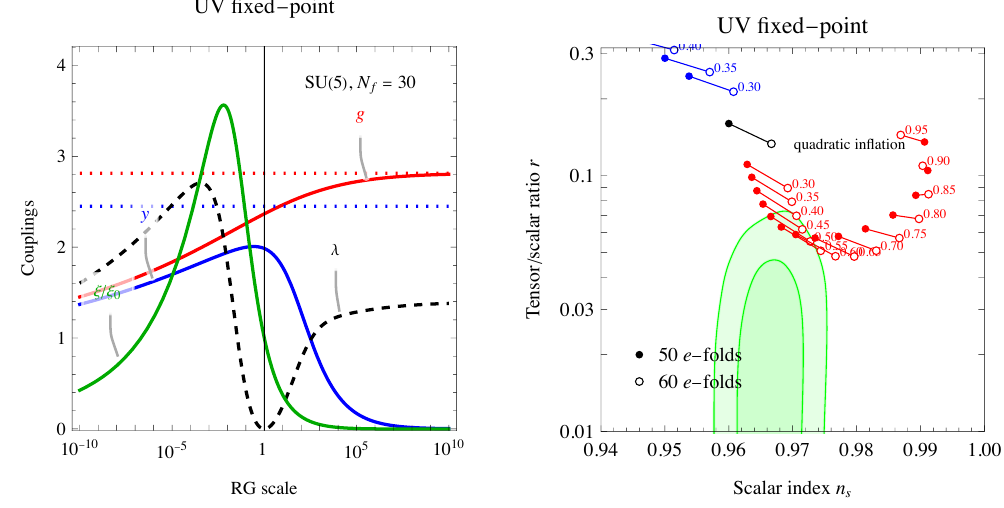
Figure 5 . Inflation with couplings that approach an interacting fixed point in the UV. Left : sample of RG running in the model of section 4.5 with N = 5 and N and large-field (blue) inflationary predictions for different values of g